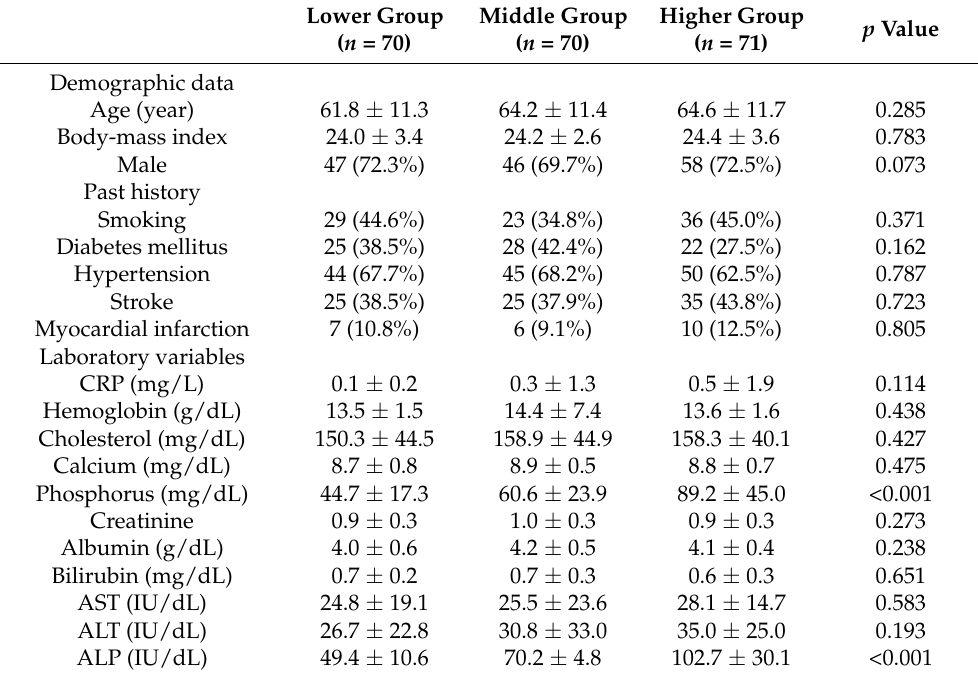
Table 1. Demographic data according to the level of ALP.